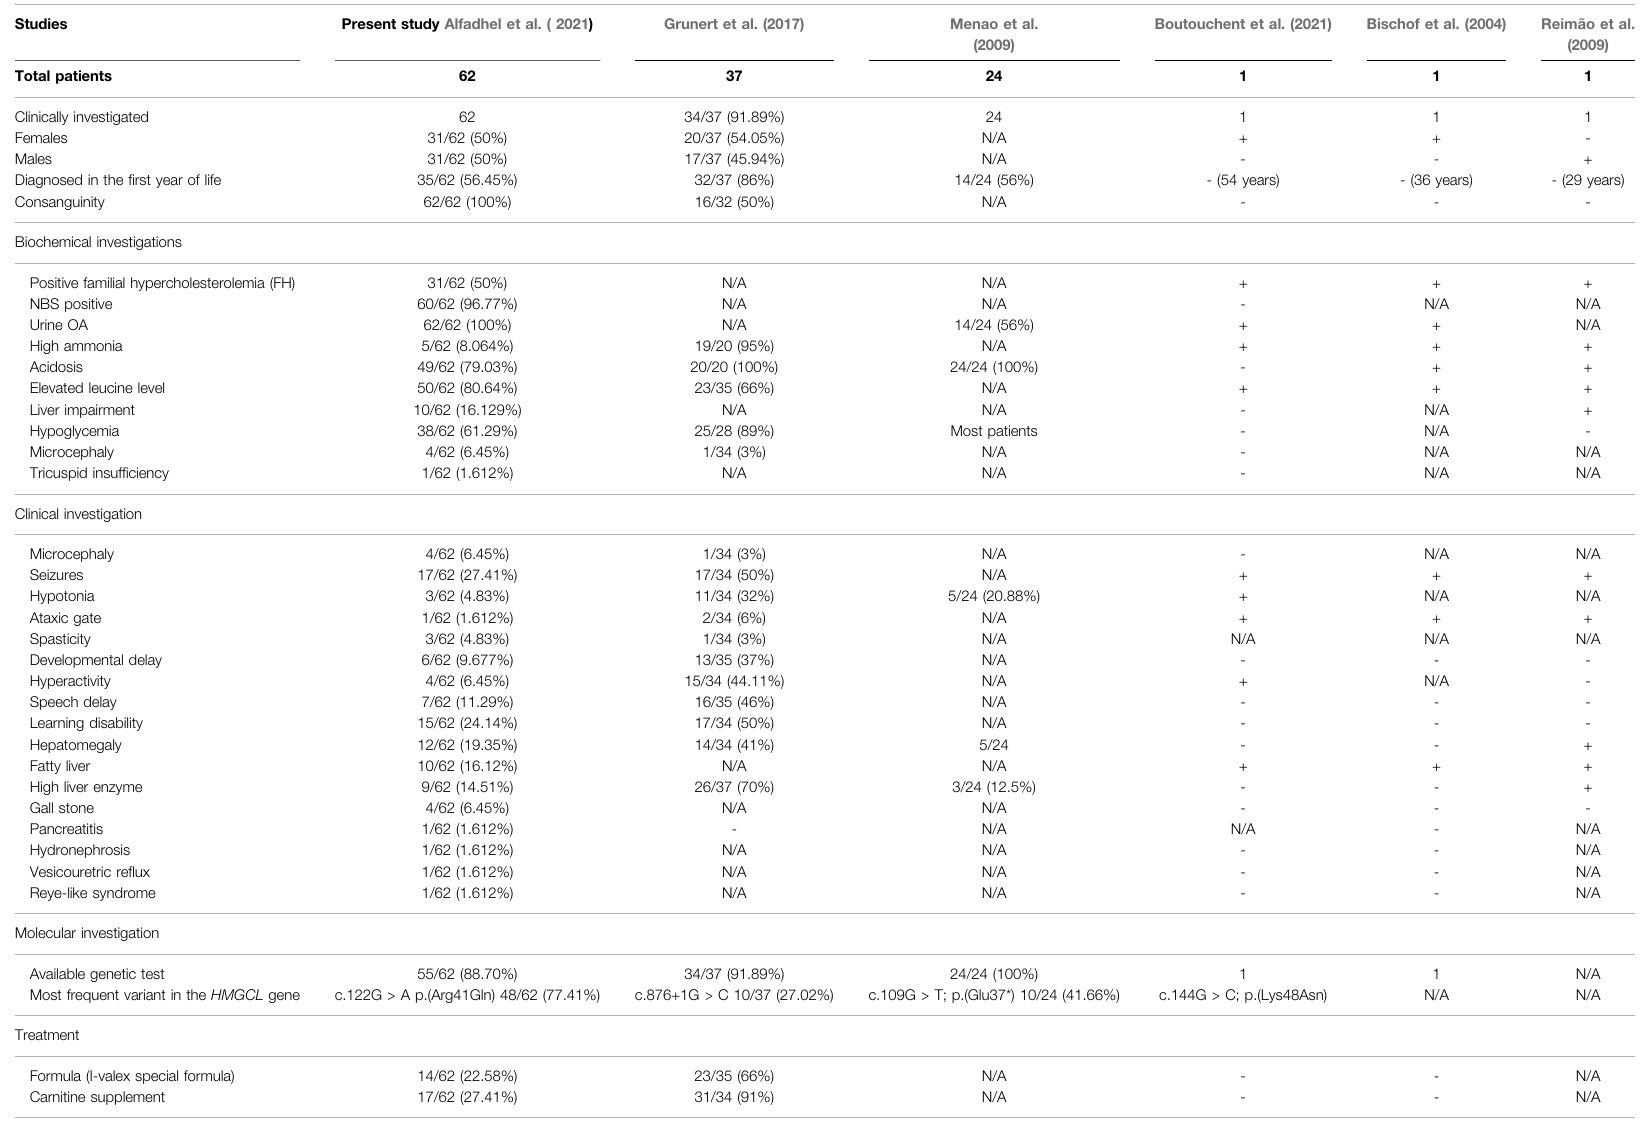
TABLE 1 | Summary of the 62 patients investigated in the present study compared to already reported cases in the literature.